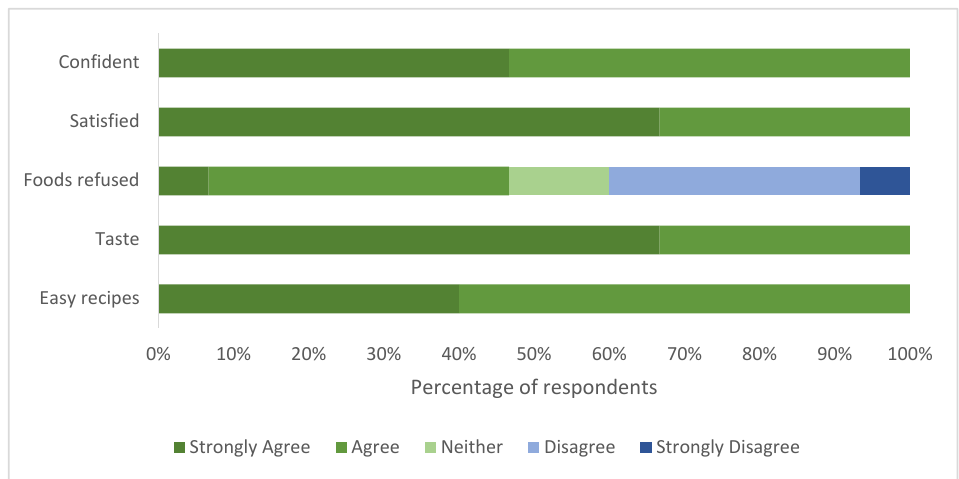
Figure 5. Intervention participant ( n = 15) opinions on the acceptability and ease of preparation of the foods on the AusMed diet program and confidence in ability to adhere.